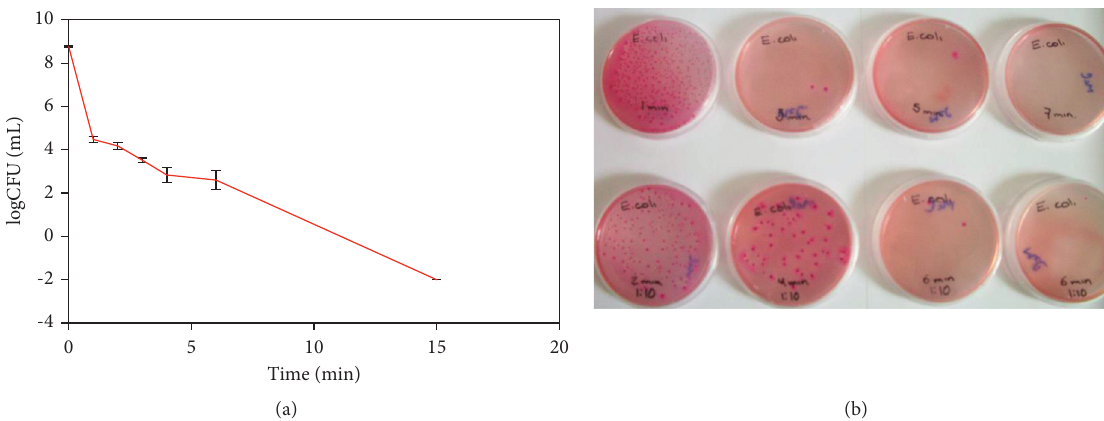
Figure 1: Biomass reduction. (a) Death kinetics of Escherichia coli ATCC 25922; (b) Escherichia coli ATCC 25922 cell in Petri dishes.